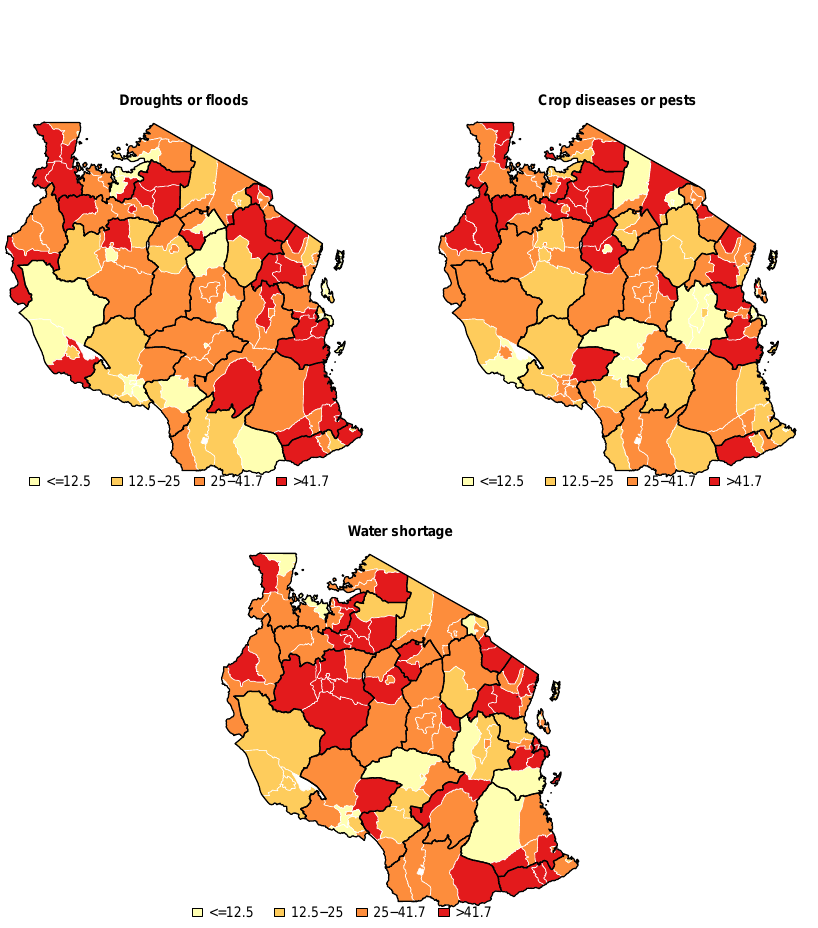
Figure 2 – Perceived environmental shocks by Tanzanian households across